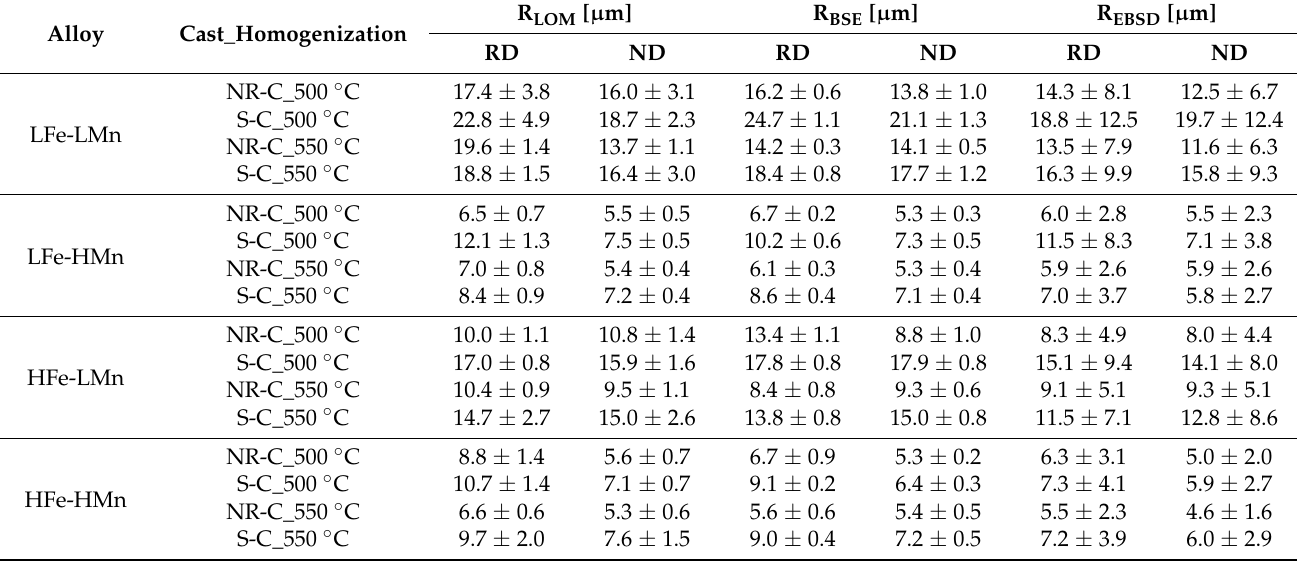
Table 2. Grain size results for 63% CRD samples from LOM, BSE and EBSD